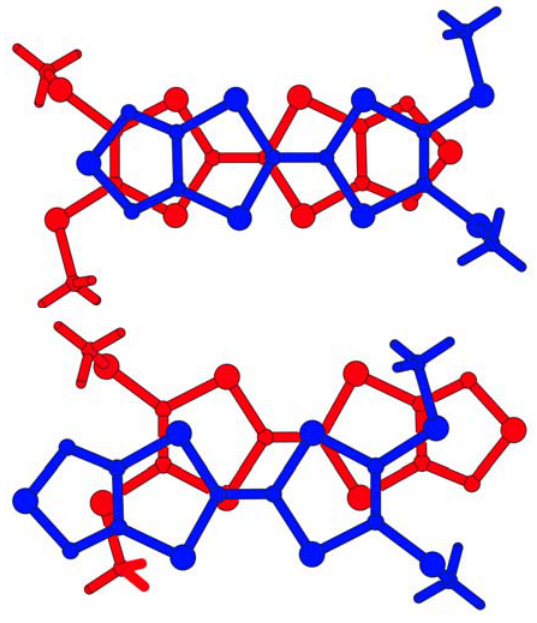
Figure 5. The overlap modes of the dimer in the crystal structure of 1 , the intradimer (upper) and interdimer (lower)